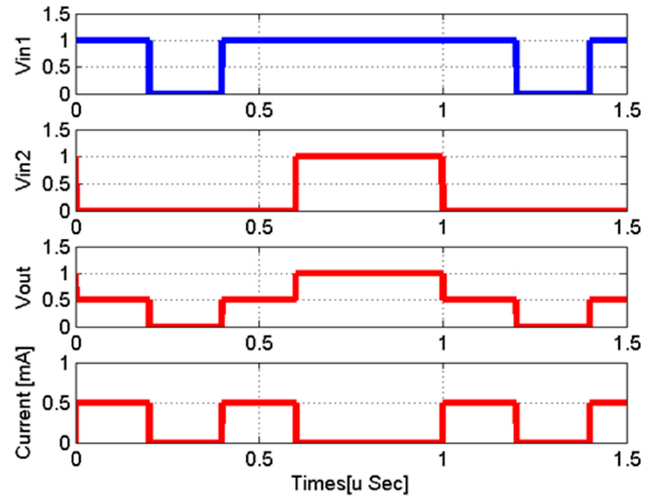
Figure 8. Simulation of the proposed DAC cell with the following sequence of inputs for ( V in 1 , V in 2 ): (0,0), (1,0), (1,1), (1,0), and (0,0).